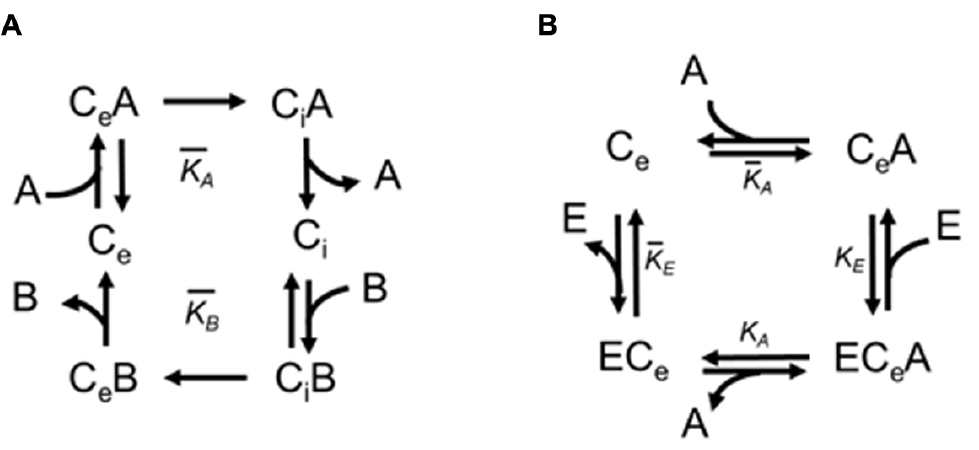
Figure 9. Schematic catalytic cycle. Panel ( A ) shows a simplified schematic representation of the catalytic transport cycle of the carrier (C) with the two substrates malate (A) and 2-oxoglutarate (B) with the corresponding equilibrium constants. Panel ( B ) shows the catalytic reactions with the equilibrium constants in the presence of hemin (E) (preloaded within proteoliposomes), with the formation of the ternary complex. “Ce” and “Ci” indicate the two possible conformations that the carrier undergoes along the transport cycle, i.e., open towards the intermembrane space ,“Ce”, or towards the mitochondrial matrix, “Ci.”